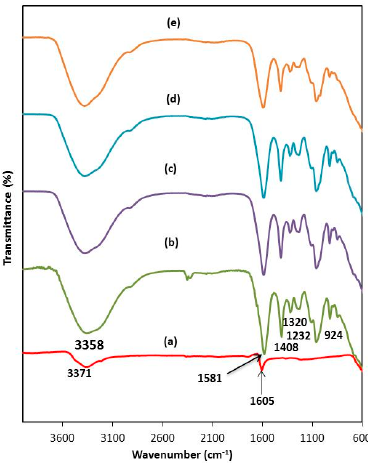
Figure 2. FTIR spectra of ( a ) LiI and CMKC/CMCE-salt films containing ( b ) 0; ( c ) 10; ( d ) 20 and ( e ) 30 wt % LiI.